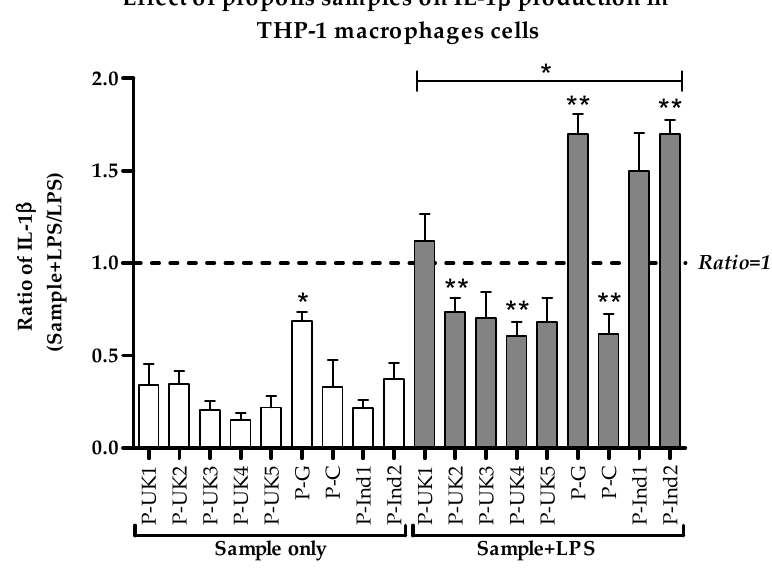
Figure 3. Effect of propolis extracts on the production of IL-1 β by phorbol 12-myristate 13-acetate (PMA)-differentiated THP-1 cells in the absence and presence of LPS (0.5 µg/mL). All nine combined treatments were significantly different from the negative control cells ( n = 3). LPS: Lipopolysaccharides; *: Significant ( p < 0.05) when compared with untreated control; **: Significant ( p < 0.05) when compared with LPS alone; P-UK (1–5): Five propolis extracts from the UK; P-G: Propolis from Ghana; P-C: Propolis from Cameroon; P-Ind (1 and 2): Two Propolis extracts from Indonesia.